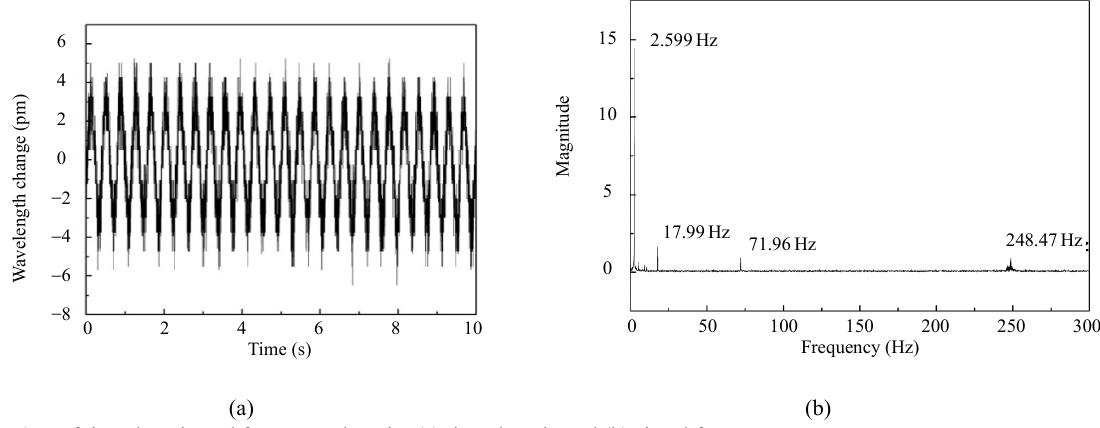
Fig. 3 Leaf time domain and frequency domain: (a) time domain and (b) signal frequency